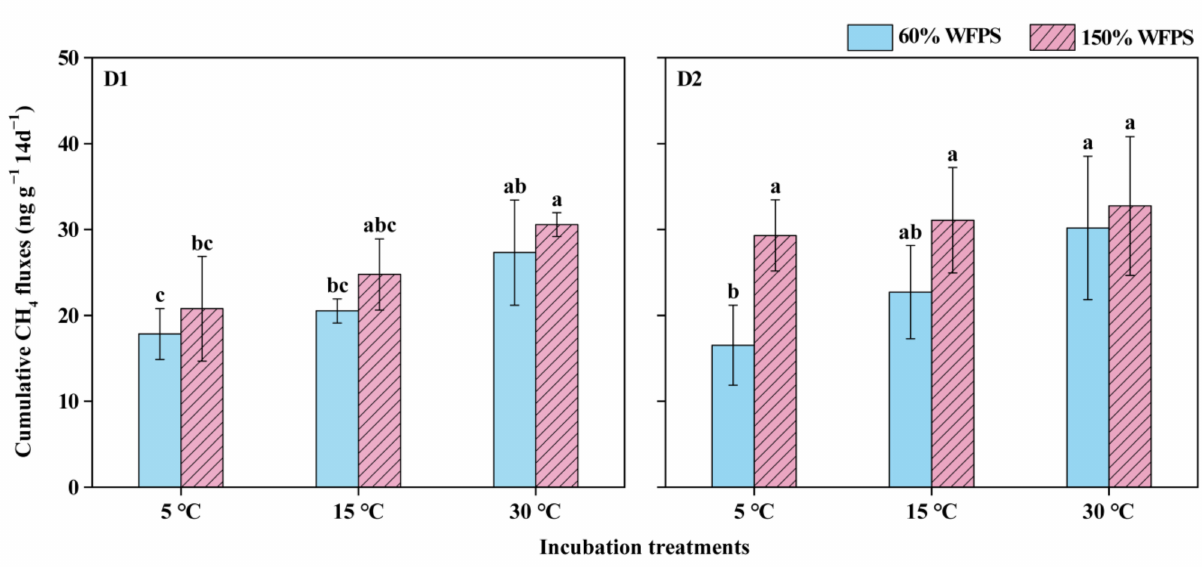
Figure 1. Soil cumulative CH 4 fluxes (ng g − 1 14d − 1 ) during a 2-week incubation period. The left and right figures show cumulative CH 4 fluxes for the different incubation treatments comprising three temperatures (5, 15, and 30 ◦ C) and two soil moisture states (60% and 150% WFPS) for two soil depths (D1: surface soil from 0–20 cm and D2: subsurface soil from 20–50 cm). Different lowercase letters indicate significant differences between treatments ( p < 0.05). WFPS: water-filled pore space. Table 1. CH 4 efflux rates during a 2-week incubation period (ng g − 1 d − 1 ), means ± standard deviation (SD, n = 3), and Q 10 values for two soil depths (D1: 0–20 cm; D2: 20–50 cm) in a poplar plantation. WFPS: water-filled pore space. Depth